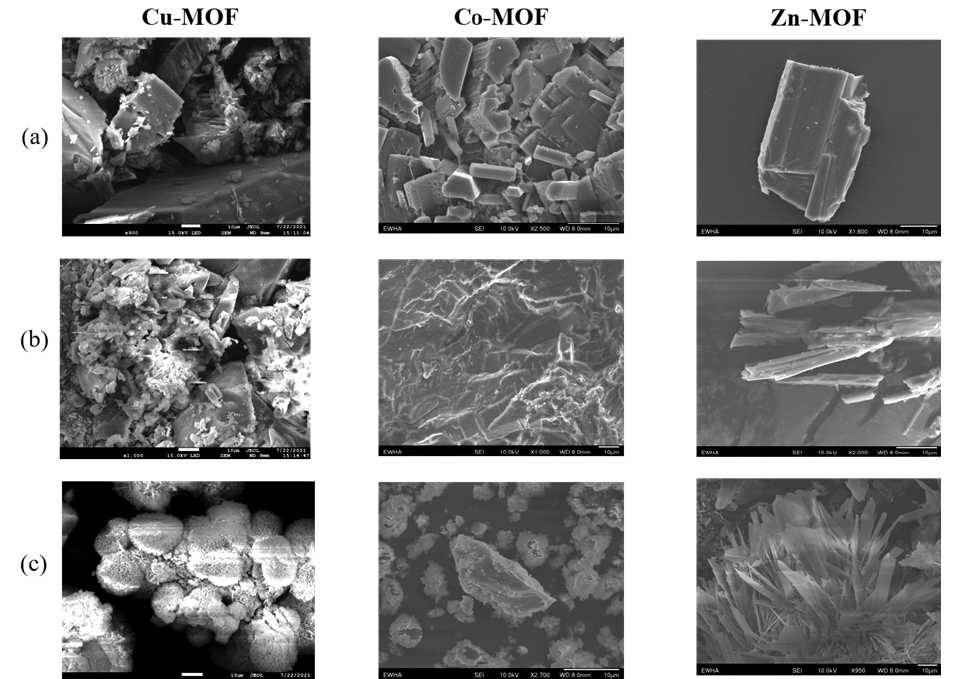
Figure 5. SEM images of ( a ) as-prepared MOFs, ( b ) MOFs after immersion in H 2 O for 1 day, and ( c ) MOFs after immersion in Dulbecco’s PBS for 1 day; MOFs: Cu-MOF, Co-MOF, and Zn-MOF (scale bar: 10 µm).